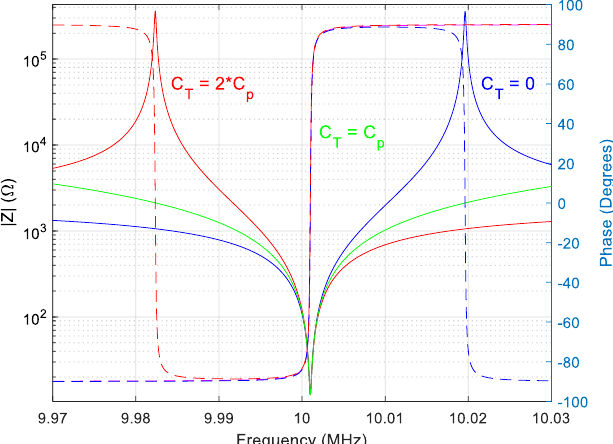
Figure 4. Simulation of the impedance (-) and phase (--) of the QCM sensor depending on the com- pensation capacitance: non-compensated ( 𝐶 𝑇 = 0 ), compensated ( 𝐶 𝑇 = 𝐶 𝑝 ), and double compen- sated ( 𝐶 𝑇 = 2 ∗ 𝐶 𝑝 ).